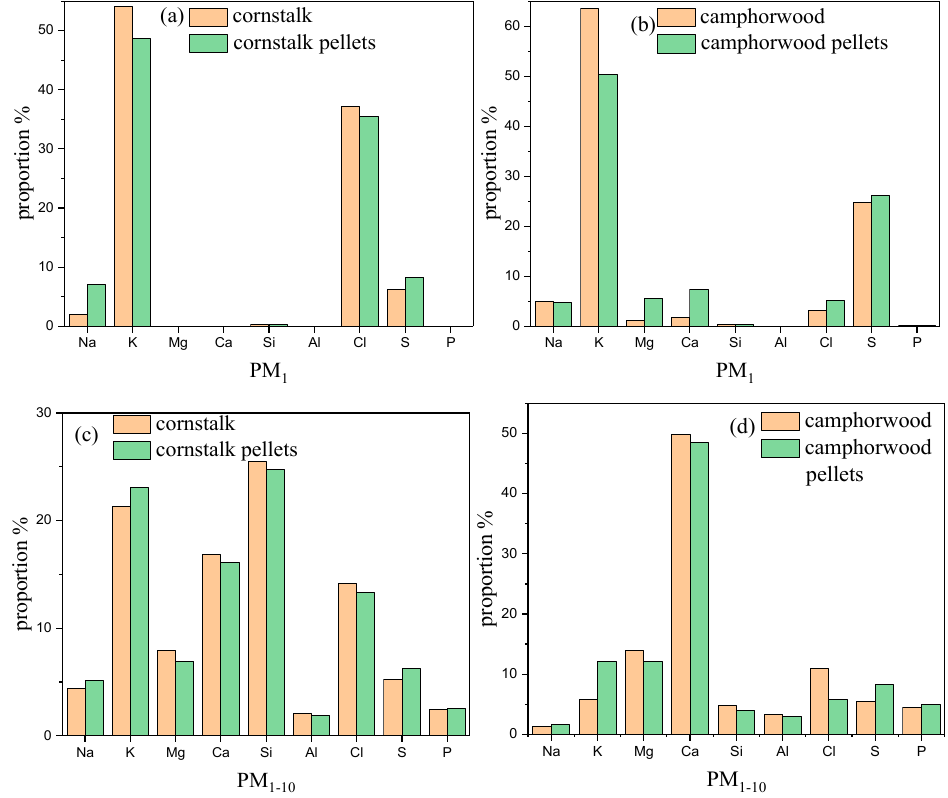
Figure 3. Particle size distributions (PSDs) of PM 10 from biomass combustion. ( a ) cornstalk and cornstalk pellet; ( b ) camphorwood and camphorwood pellet.